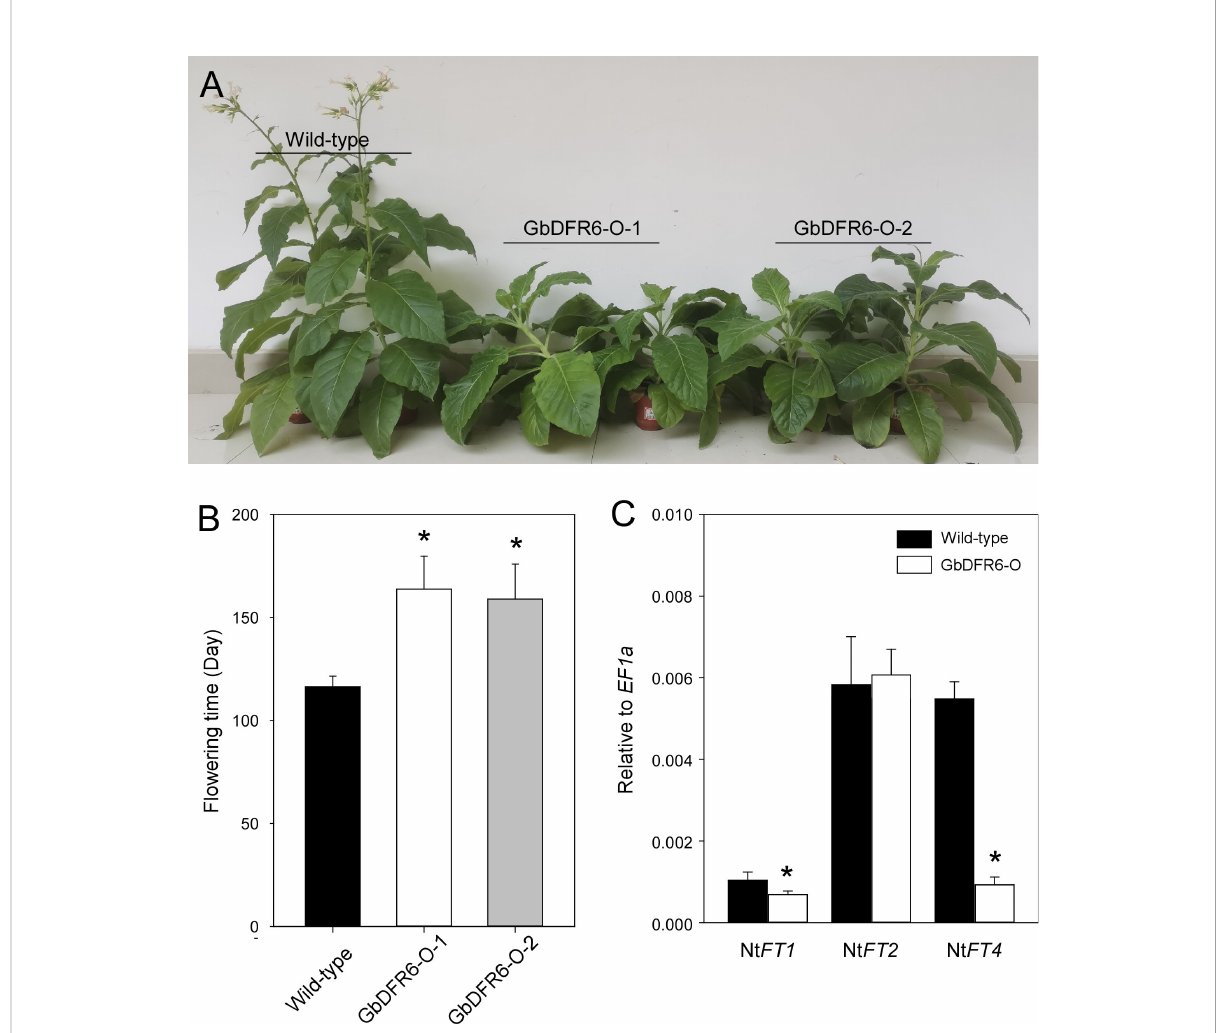
FIGURE 4 Comparative analysis of fl owering time between wild-type and transgenic tobacco plants under short-day conditions. (A) Morphological comparison of fl owering time between wild-type and transgenic tobacco plants. Two transgenic lines exhibited delayed bolting and fl owering times when compared to the wild-type tobacco plants. (B) Comparison of fl owering days between wild-type and two transgenic tobacco lines (data are presented as means ± SD; n = 10; * indicates signi fi cant differences, P < 0.01; Student ’ s t -test). (C) Expression of NtFTs in tobacco plants before bolting as determined by quantitative reverse transcription polymerase chain reaction. The expressions levels of NtFT1 and NtFT4 were signi fi cantly downregulated in transgenic tobacco plants (data are presented as means ± SD; n = 4; * indicate signi fi cant differences, P < 0.01; Student ’ s t